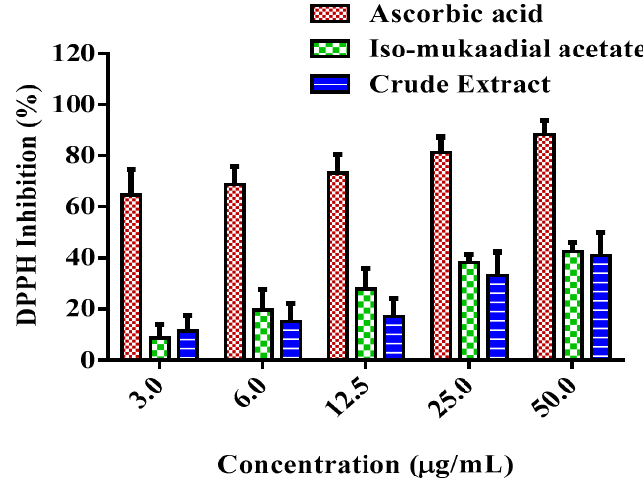
Figure 8. Percentage DPPH inhibition activity of standard compound ascorbic acid, iso-mukaadial acetate, and crude extract. Values are presented as means, and vertical bars indicate SEM, p < 0.05.